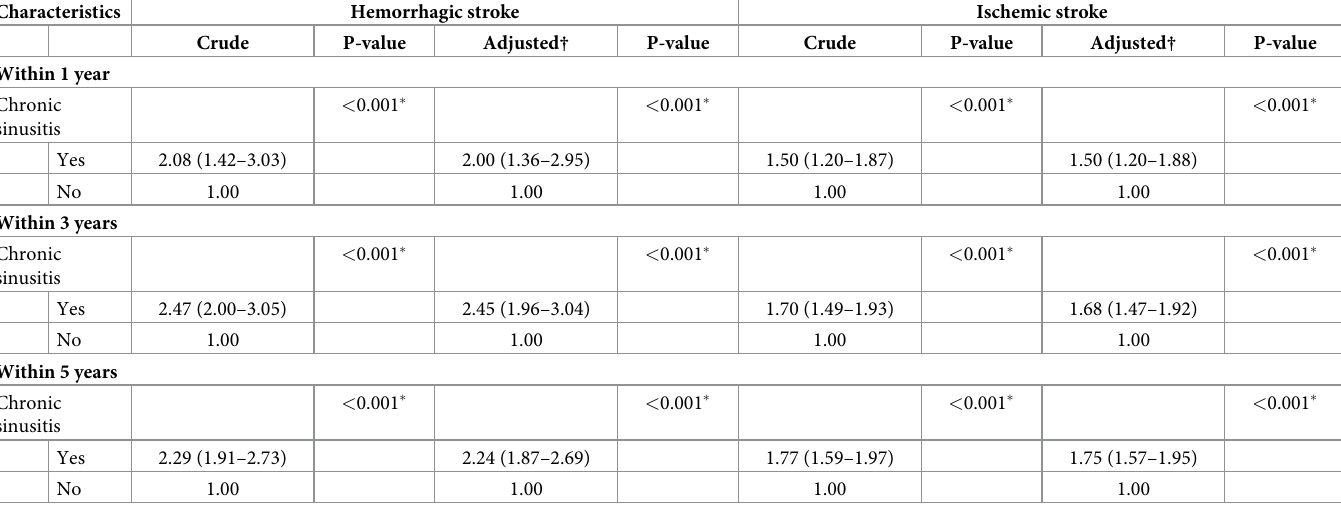
Table 4. Subgroup analysis of crude and adjusted hazard ratios (95% confidence interval) of chronic sinusitis for hemorrhagic stroke and ischemic stroke according to follow up periods.